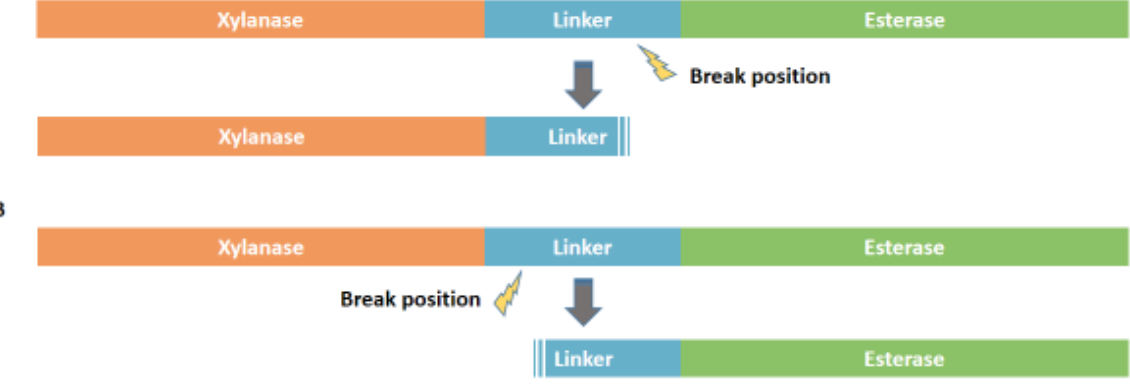
N represents the number of each residue; % represents the percentage of each residue.